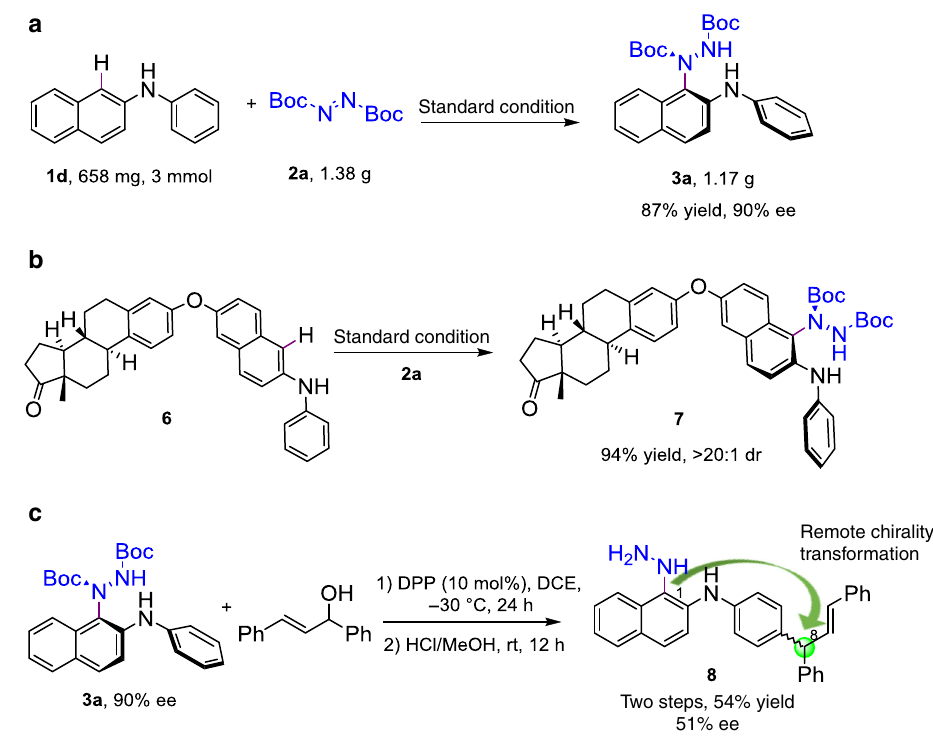
Fig. 5 Synthetic applicability. a Gram-scale synthesis of 3a . b The feasibility of complex molecule. c The chirality transfer